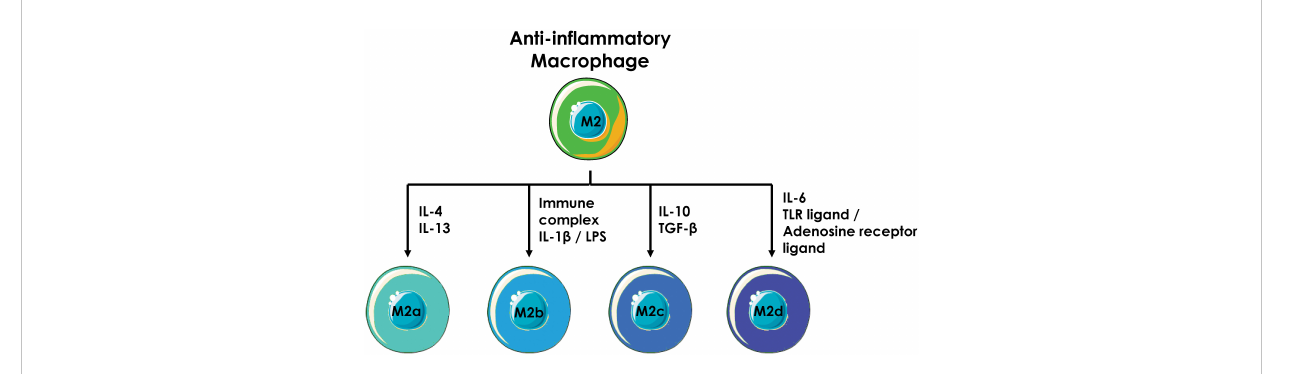
FIGURE 5 Anti-in fl ammatory macrophage polarization. Anti-in fl ammatory macrophages are divided into four subpopulations, each of which is generated by different